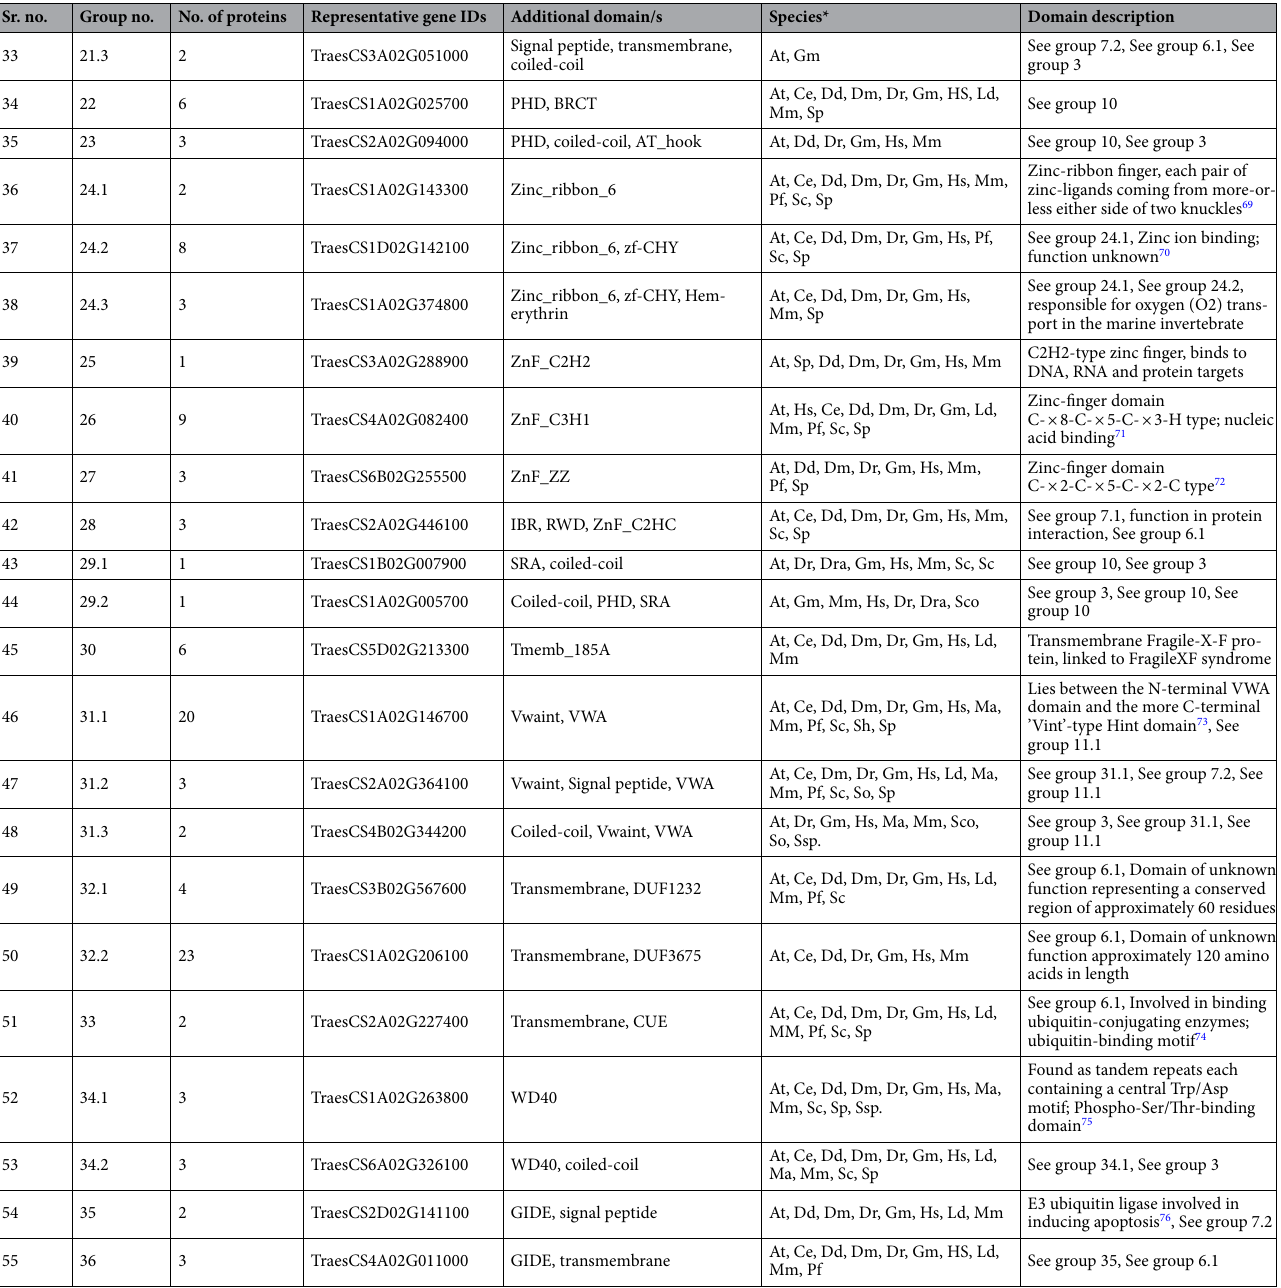
Table 1. Wheat RING domain containing proteins grouped based on the presence or absence and organization of the additional domain/s in RING proteins. The possible wheat RING protein orthologs in other species are shown. *Species having similar domain architecture in RING proteins determined by NCBI BLASTp search in model organisms (landmark) database only. At: Arabidopsis thaliana , Cd: Clostridioides difficile, Ce: C. elegans, Dd: Dictyostelium discoideum , Dm: Drosophila melanogaster , Dr: Danio rerio , Dra: Deinococcus radiodurans , Gm: Glycine max , Hs: Homo sapiens , Ld: Leishmania donovani , Ma: Microcystis aeruginosa , Mm: M. musculus , Pa: Pseudomonas aeruginosa , Pf: Plasmodium falciparum , Sc: Saccharomyces cerevisiae , Sco: S treptomyces coelicolor , So: Shewanella oneidensis, Sp: Schizosaccharomyces pombe, Spn: Streptococcus pneumonia , Ssp.: Synechocystis sp., Xl: Xenopuslaevis, Zm: Zea